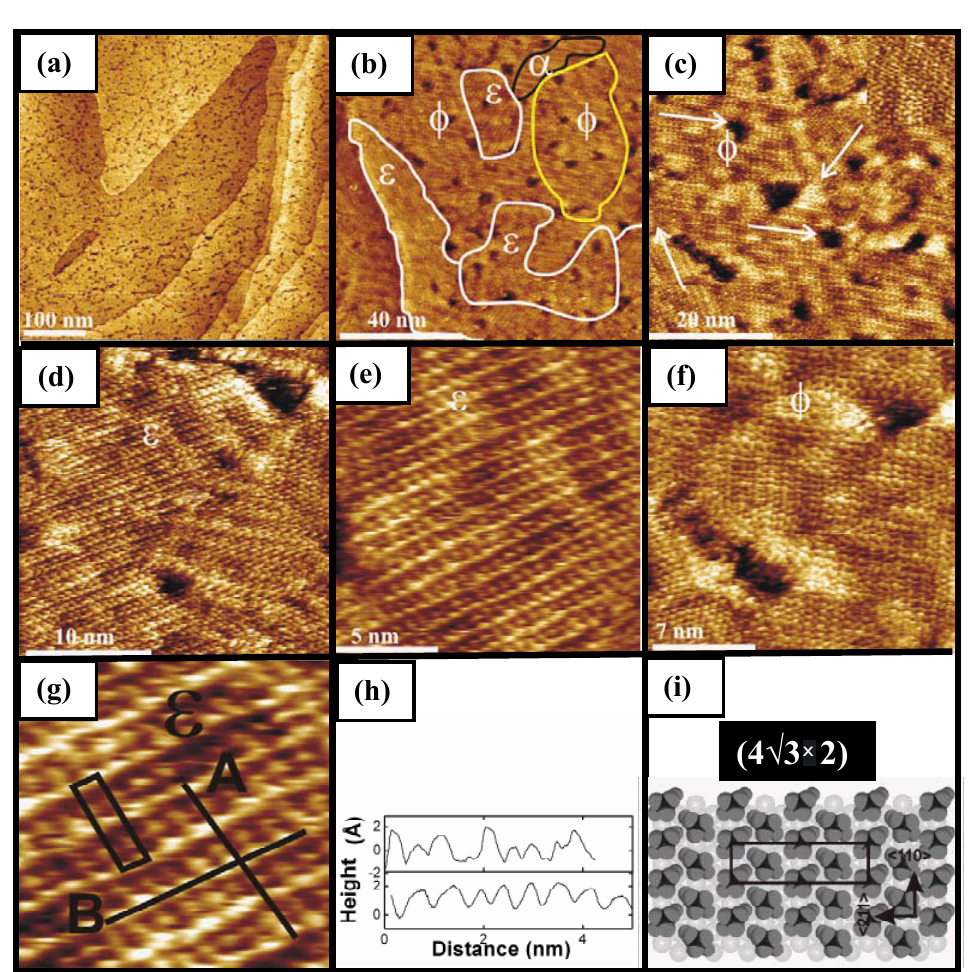
Figure 8. (a-g) constant-current STM images showing the gold surface after immersion into 100 μM ethanolic solution of BP2 at 348 K for 72 h. The arrows in (c) show the different directions of the φ -phase domains. The unit cell of the (4 √ 3×2) structure is marked by the rectangular in (g). (h) cross-sectional height profiles along the lines A and B labeled in (g). (i) top views of (4 √ 3×2) model. (a) U= 1000 mV; I= 501 pA, (b) U= 1000 mV; I= 501 pA, (c) U= 550 mV; I= 350 pA, (d) U= 550 mV; I= 300 pA, (e) U= 531 mV; I= 200